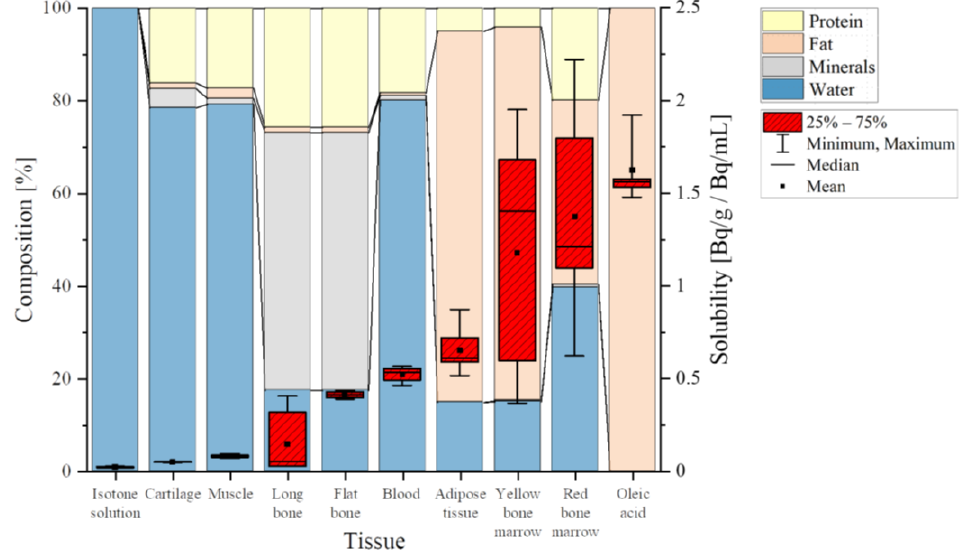
Figure 5. Solubility data (red boxes) and tissue composition divided into protein (yellow), fat (orange), minerals (grey) and water (blue) for different samples and tissues; data for tissue composition obtained from (14), same data for long and flat bones.